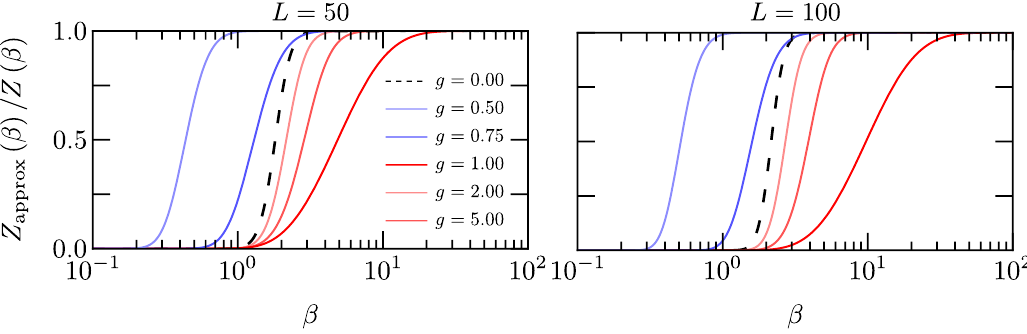
Figure 2: Ratio between the low-temperature approximation and exact partition functions as a function of the inverse temperature. The accuracy of the two-level ap- proximation (53) is considered for different values of the transverse magnetic field g and two different system sizes. As the energy gaps δ ( g ) and ∆ ( g ) in the neighbour- = 1 are comparable, a lower temperature is required to obtain a desired hood of g c level of accuracy. For given β , the accuracy decreases with increasing system